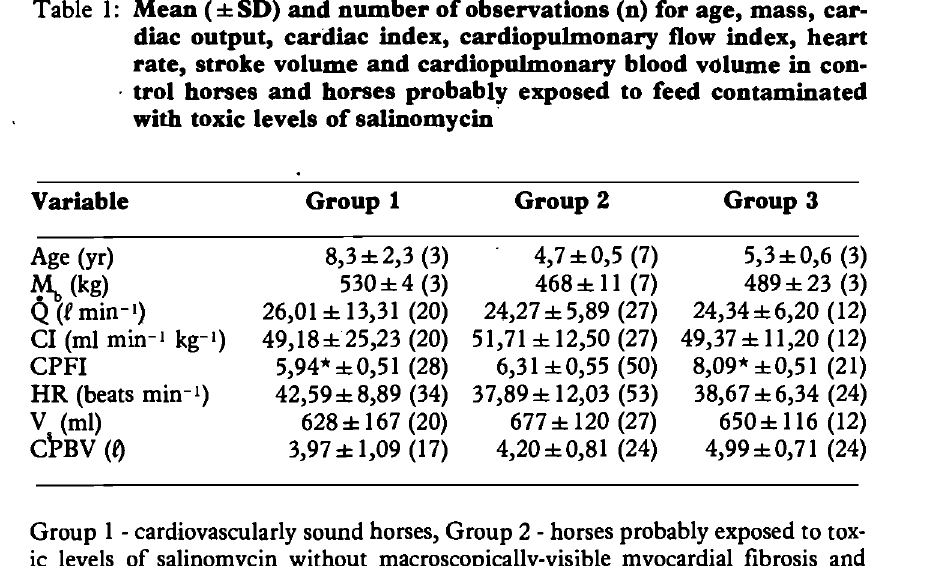
Group I - cardiovascularly sound horses, Group 2 - horses probably exposed to tox ic levels of salinomycin without macroscopically-visible myocardial fibrosis and Group 3 - diseased horses with macroscopically-visible myocardial fibrosis Q = A\ = Body mass, Cardiac output, CI = Cardac index, CPFI = Car diopulmonary flow index, HR = Heart rate, V, = Stroke volume, CPBV = Car diopulmonary blood volume *- signifies that the means are significantly different at P < 0,05